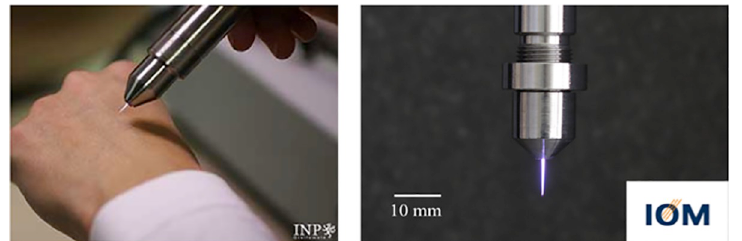
Fig 1. Plasma sources. Plasma source kINPen09 (INP, Greifswald, Germany) (left) and plasma source PS-MWM (IOM, Leipzig, Germany) (right).